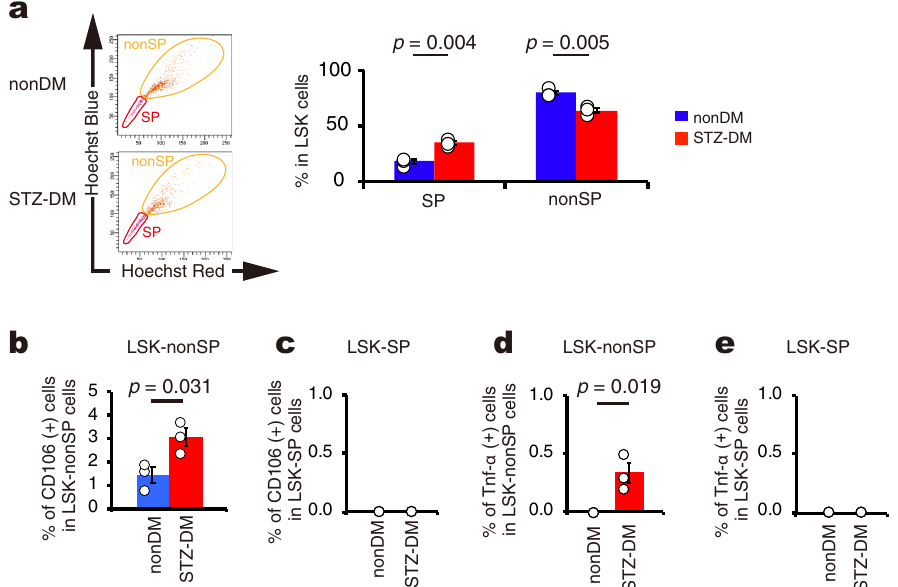
Fig. 4 CD106- or TNF- α -positive cells exist in the nonSP fraction of LSK cells in STZ-DM. a FACS analysis of SP and/or nonSP fraction in the LSK cells from nonDM and STZ-DM (left panel, SP cells surrounded by red circle, nonSP cells surrounded by orange circle). Percentage of SP fraction or nonSP fraction in LSK cells from mononuclear cells in nonDM and STZ-DM (right panel, n = 3 per group). b FACS analysis of CD106-positive cells in LSK-nonSP cells from nonDM and STZ-DM. Percentage of CD106-positive cells in LSK-nonSP cells from mononuclear cells in nonDM and STZ-DM ( n = 3 per group). c FACS analysis of CD106-positive cells in LSK-SP cells from nonDM and STZ-DM. Percentage of CD106-positive cells in LSK-SP cells from mononuclear cells in nonDM and STZ-DM ( n = 3 per group). No CD106-positive cells were detected in any of the mice. d FACS analysis of TNF- α -positive cells in LSK- nonSP cells from nonDM and STZ-DM. Percentage of TNF- α -positive cells in LSK-nonSP from mononuclear cells in nonDM and STZ-DM ( n = 3 per group). e FACS analysis of TNF- α -positive cells in LSK-SP cells from nonDM and STZ-DM. Percentage of TNF- α -positive cells in LSK-SP from mononuclear cells in nonDM and STZ-DM ( n = 3 per group). No TNF- α -positive cells were detected in any mice. Data are indicated as means ±